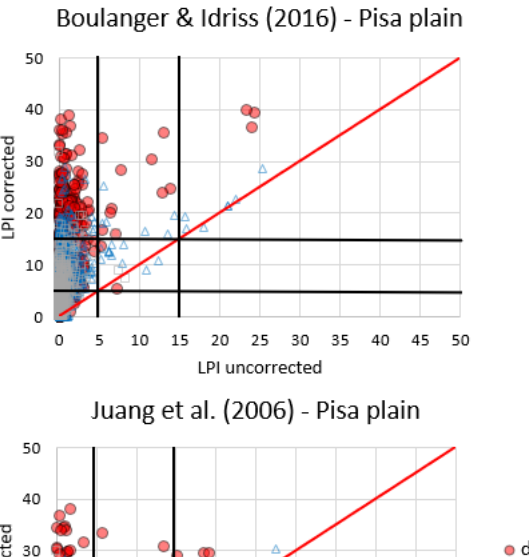
Figure 16. LPI (corrected) vs. LPI (w/o corrections) for the macro-area of the Lucca plain.